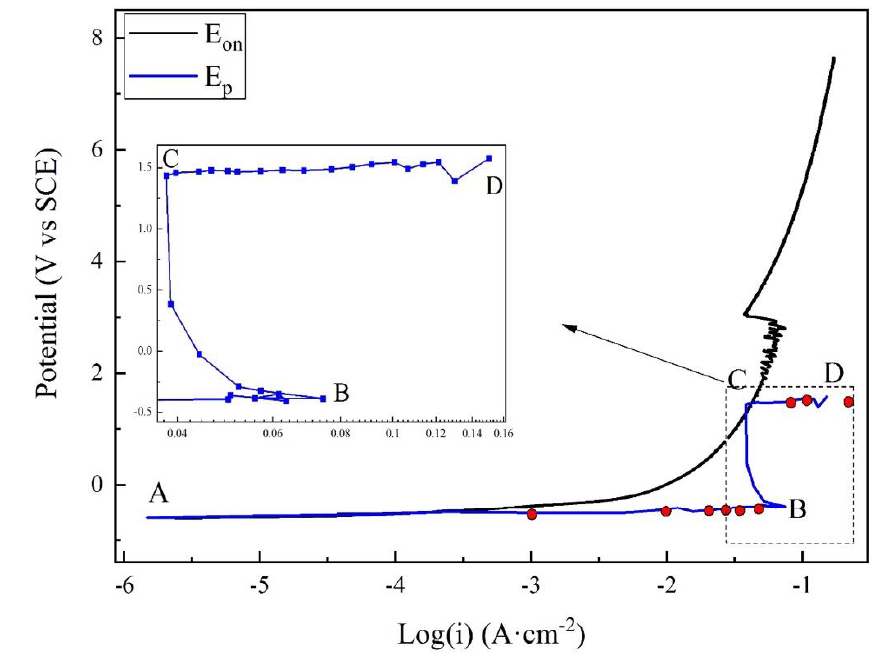
Figure 4. Comparison of apparent and real polarization curves for X80 steel in 4 g · L − 1 Na 2 SO 4 solution.